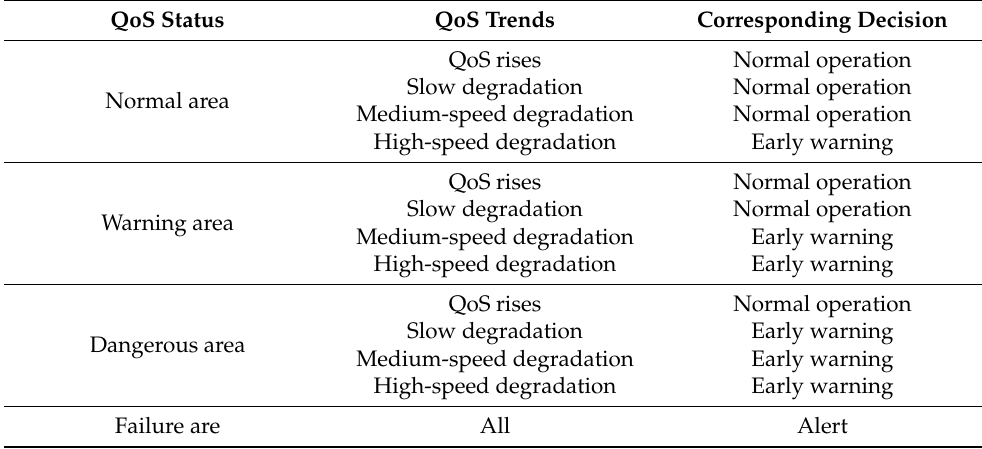
Table 1. QoS early warning decision.